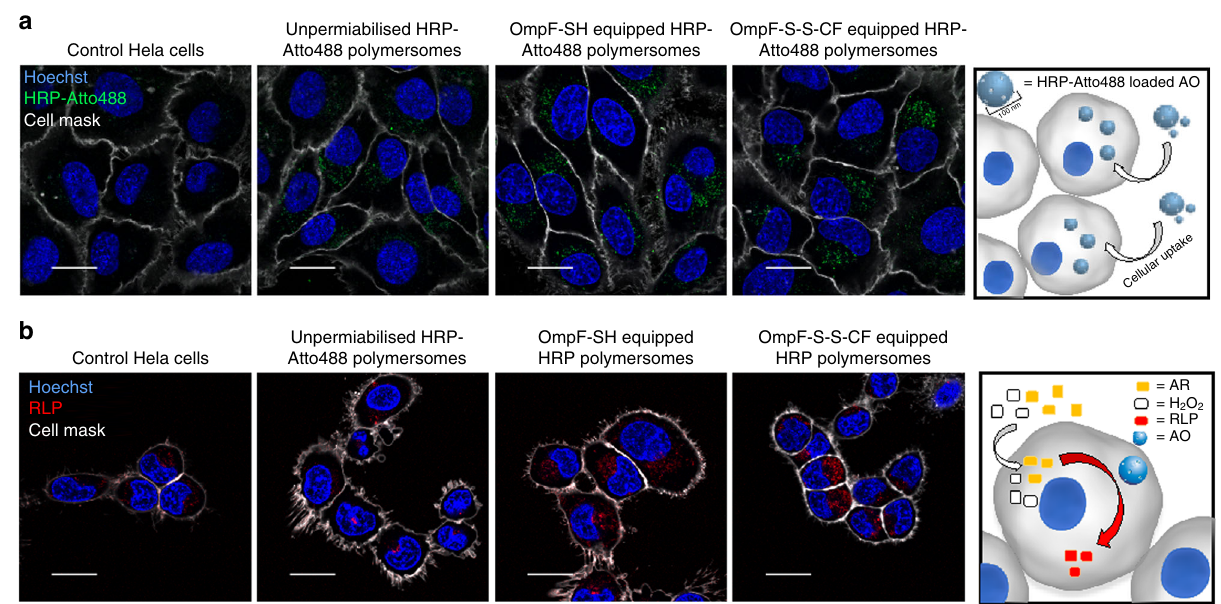
Fig. 4 Cellular uptake and intracellular activation of AOs. a Confocal fl uorescence micrographs of HeLa cells showing cellular uptake of fl uorescently labelled HRP-loaded polymersomes and AOs loaded with fl uorescently labelled HRP. Scale bar: 10 µ m. b Cellular uptake and intracellular activation of fl uorescently labelled HRP-loaded polymersomes and fl uorescently labelled HRP-loaded AOs. Blue signal: Hoechst 33342 nucleus stain. Grey signal: CellMask Deep Red Plasma membrane stain. Green signal: Atto488 HRP. Red signal: resoru fi n-like product (RLP). Scale bar 20 µ